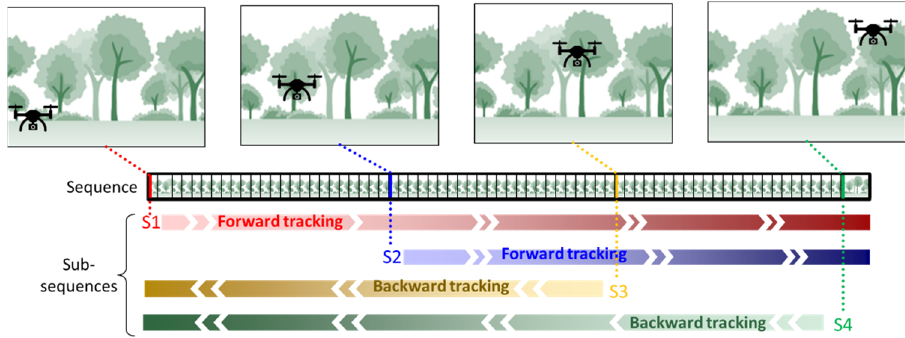
Figure 4. Starting points and tracking direction for evaluation.